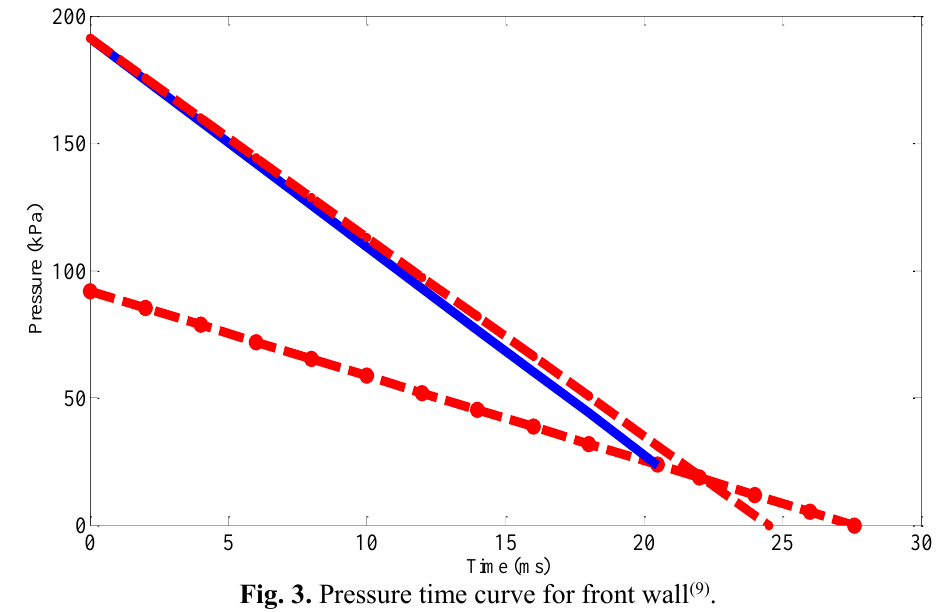
Fig. 2. Hemispherical TNT explosion on the surface at sea level of Blast wave parameters.